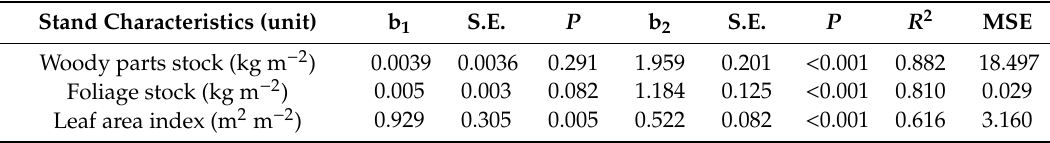
Figure 8. Leaf area index of fully-stocked common aspen stands plotted against the d 0 mean stand diameter at the stem base (see also Table 8). Table 8. Models for calculating the biomass of woody parts, foliage, and leaf area index in common aspen stands using stem base diameter as an independent variable, showing their regression coe ffi cients (b 1 , b 2 ), standard errors (S.E.), p -values ( P ), coe ffi cients of determination ( R 2 ), and mean squared errors (MSE) (see Equation